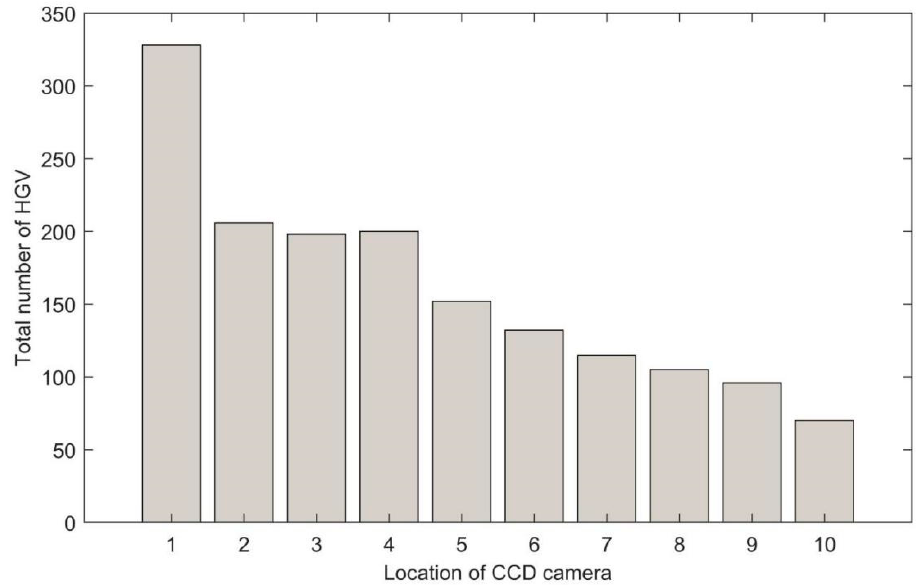
Figure 11. Total number of hazardous goods vehicles on each location from Monday to Saturday.